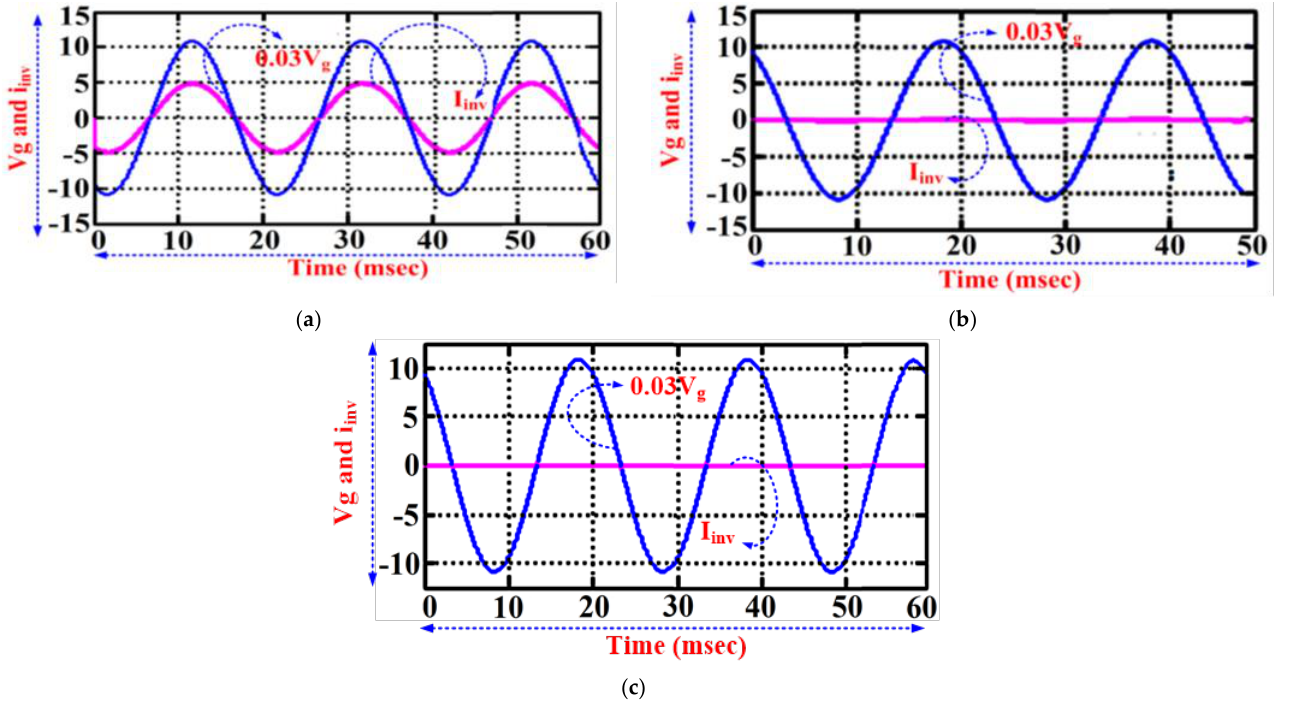
Figure 7. Steady operation under various grid-current for HCC at variable constant-frequency band. ( a ) At rated grid current, ( b ) 5% of the rated grid current, ( c ) zero grid current.